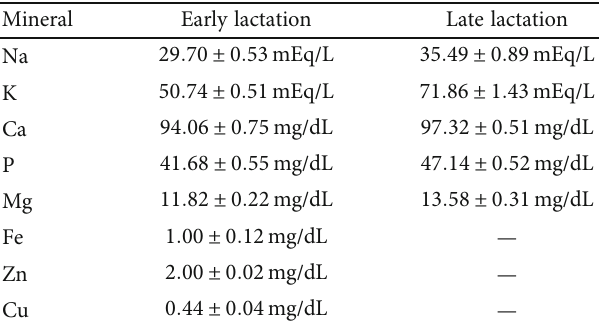
Table 5: Camel milk mineral concentration in milliequivalents per litre (mEq/L), and milligrams per deciliter (mg/dL). Mineral Early